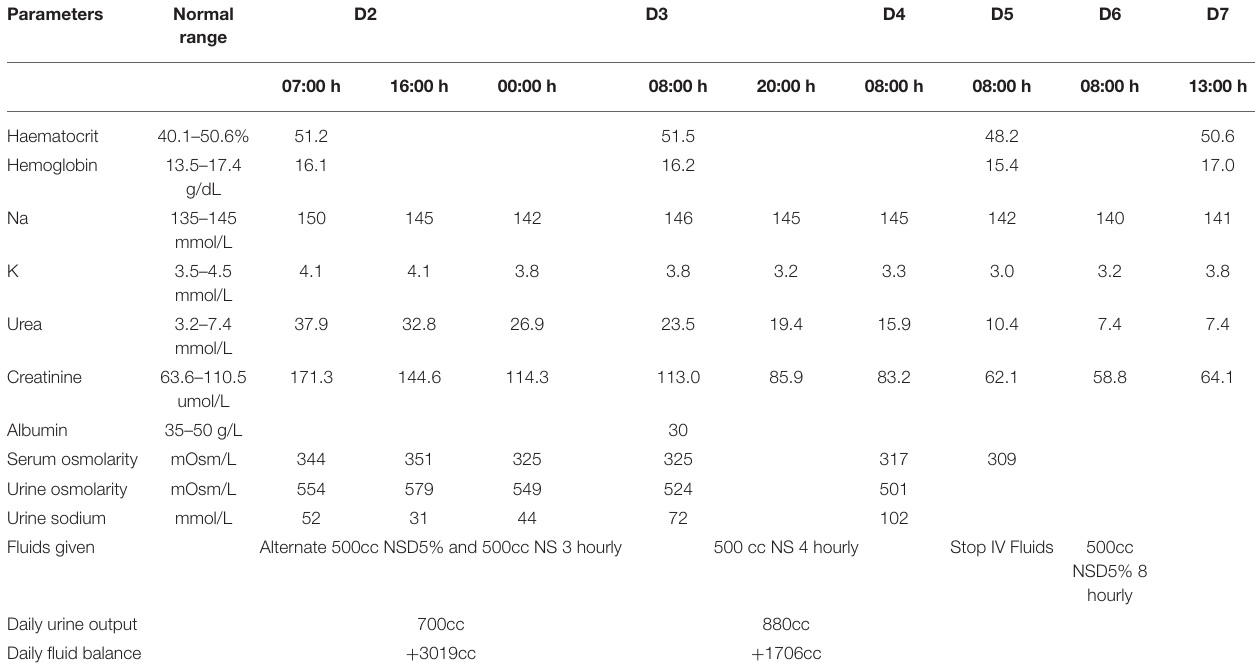
TABLE 2 | Biochemical parameters from day 2 till 7 of hospital stay.